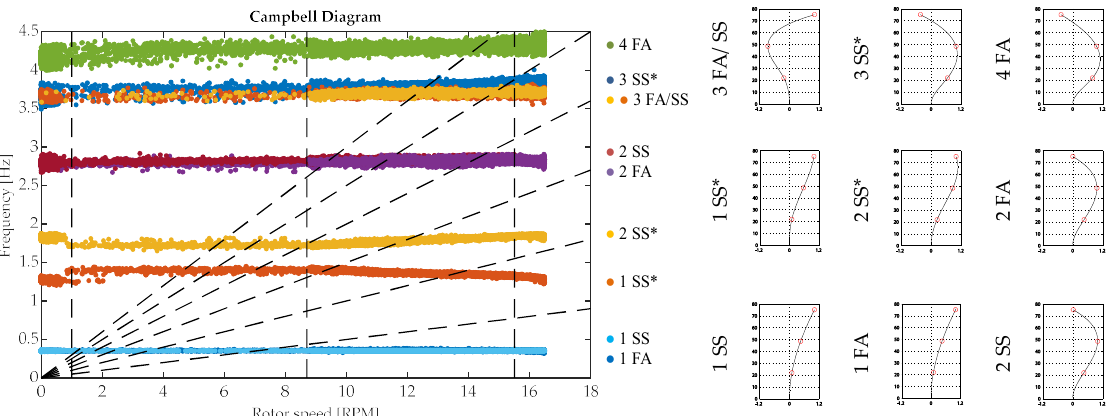
Figure 3. Campbell diagram with the tracked vibration modes (p-LSCF algorithm) in the left side and corresponding mode shapes in the right side.